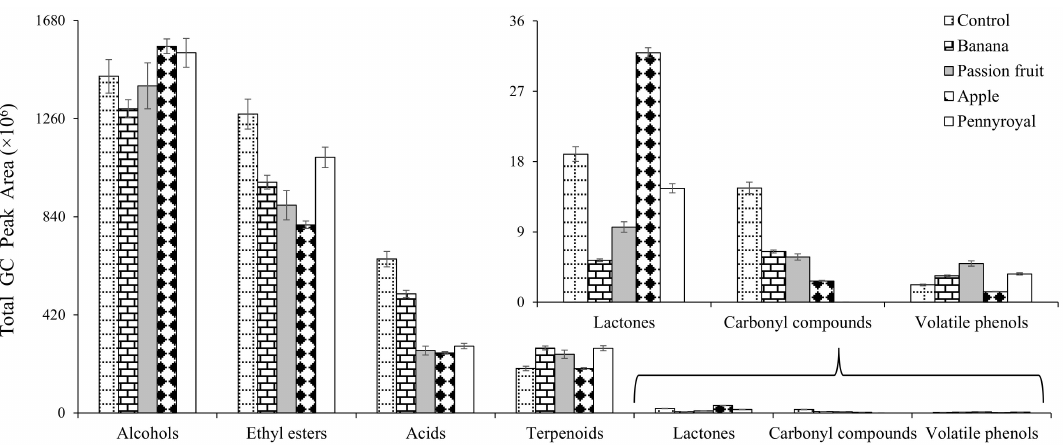
Figure 3. Total GC-MS peak area of chemical families identified in wine (control) and WBAV (banana, passion fruit, apple, pennyroyal)